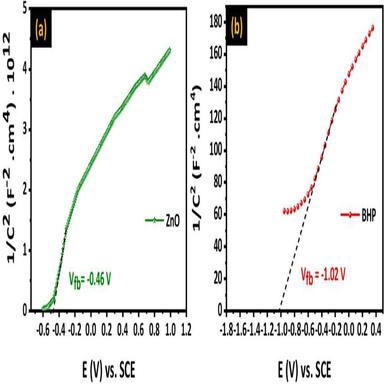
Mott-Schottky measurement for the two semiconductors (a) ZnO and (b) BHP.